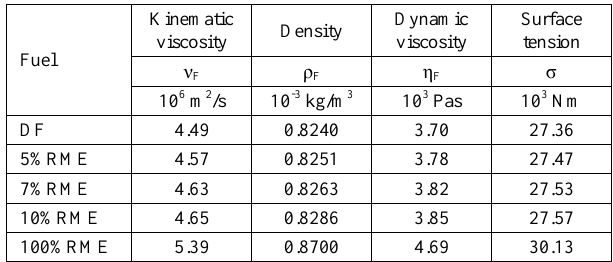
Table 2. Physical parameters of the fuels selected for the analytical and experimental studies Kinematic viscosity Fuel